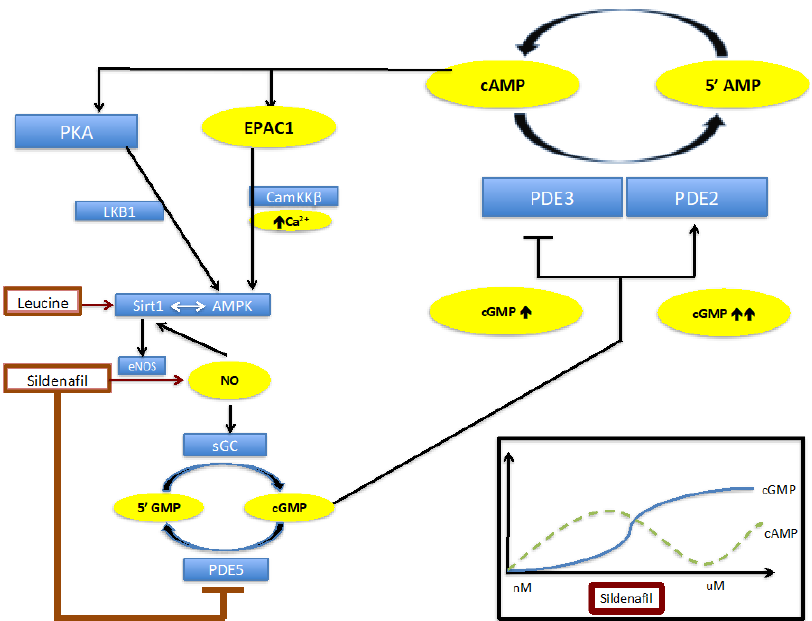
Figure 7. Schematic representation of the interaction between Sildenafil, Leucine, PDE2, and PDE3. Increasing concentrations of sildenafil cause an increase in intracellular cGMP due to eNOS/NO activation and PDE5 inhibition, which is accompanied by a biphasic response in cAMP (lower right corner). This biphasic response in cAMP is mediated by the interaction of cGMP with PDE2 and PDE3. While PDE3 is inhibited by moderate increases in cGMP and consequently cAMP concentrations rise due to reduced hydrolysis, higher levels of cGMP activate PDE2 and, therefore, decrease cAMP. These changes in cAMP are reflected in downstream events such as AMPK activation, which is most likely mediated over the cAMP-EPAC-CamKK β signaling pathway.